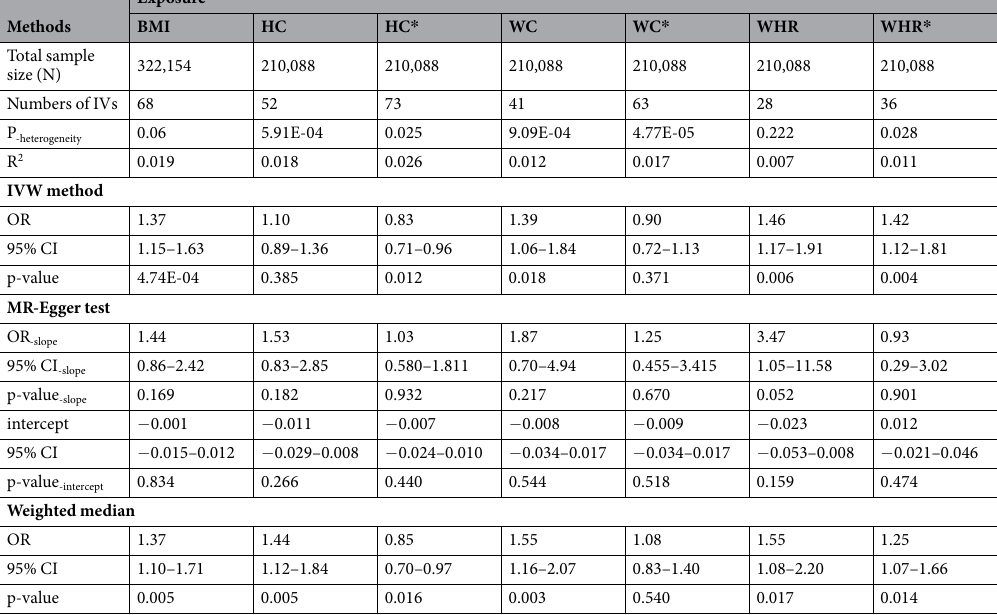
provided evidence that the risk of CAD decreased with increased BMI-adjusted HC from the IVW results (OR 0.83, 95% CI 0.71–0.96). From the MR-Egger test, the intercept did not reveal any unbalanced horizontal pleiot- ropy (intercept p = 0.440), and we found a positive but imprecise association of BMI-adjusted HC with CAD (OR